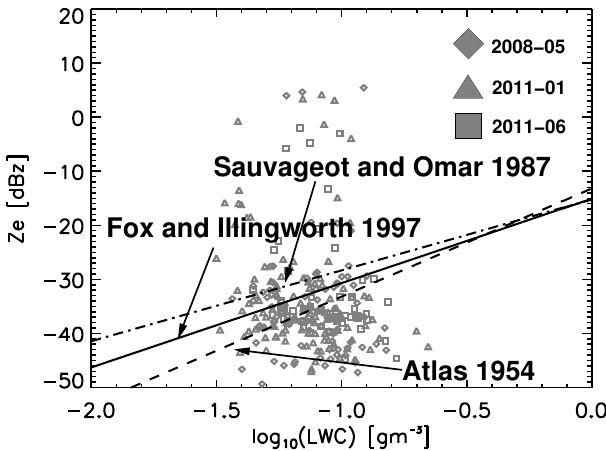
Figure B1. Relationship between observed cloud-base reflectivity and corresponding cloud-base reflectivity predicted from the depo- larisation lidar inversion results. The lines correspond to three dif- ferent Z e vs. LWC relationships as labelled, for details consult the